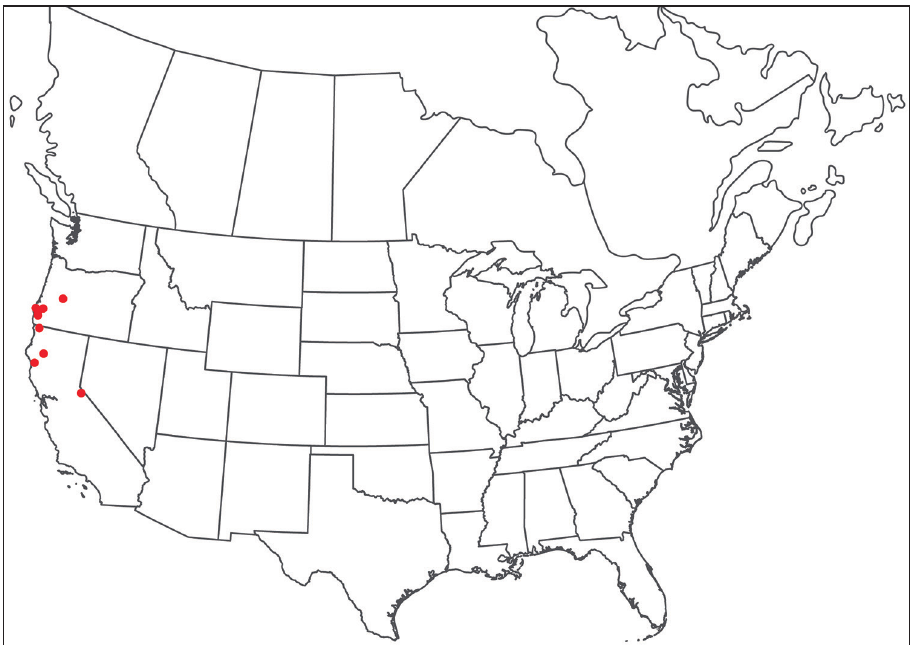
Figure 41. Torrenticola copipalpa sp. n.